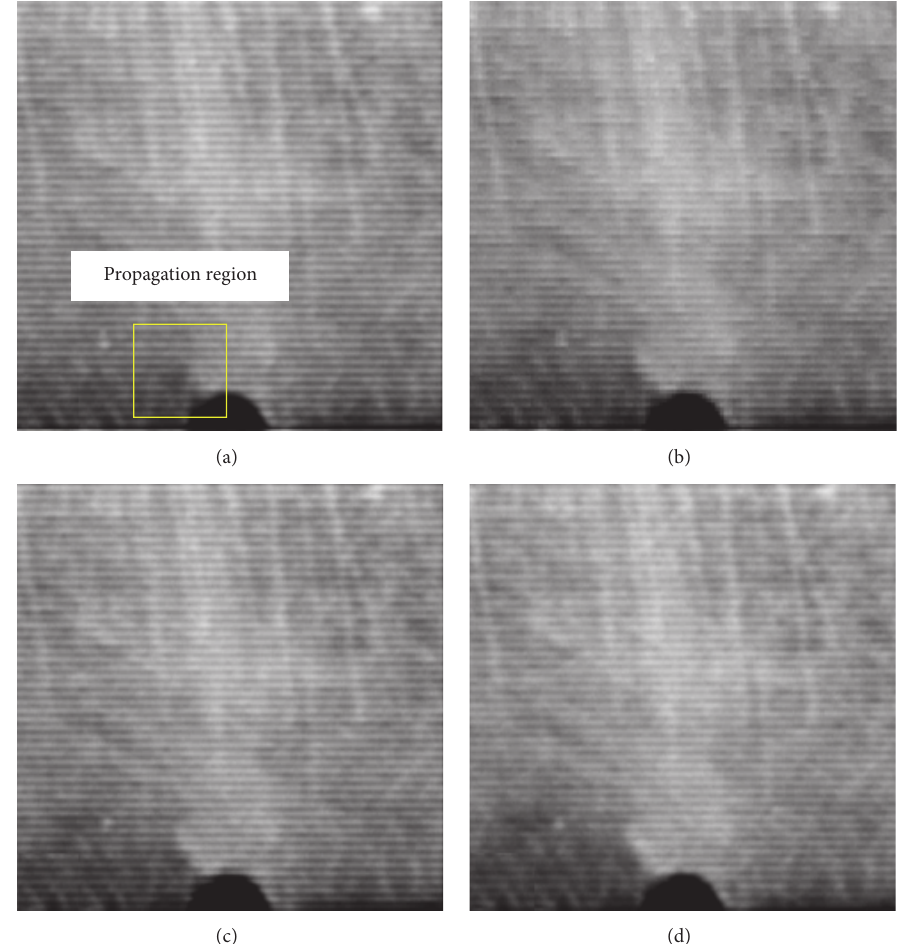
Figure 3: Gray distribution images at the same moment in different cycles.